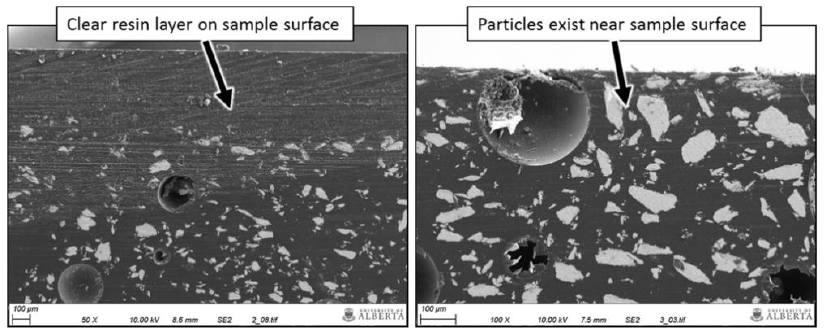
Figure 11. Scanning electron microscopy images of cross-sections of samples with 50 wt% NdFeB and 5% of anti-settling additive ( left ) or 10% of the additive ( right ), respectively. The top of the micrographs corresponds to the samples’ upper surfaces. Reprinted from [86], originally published under a CC-BY license.